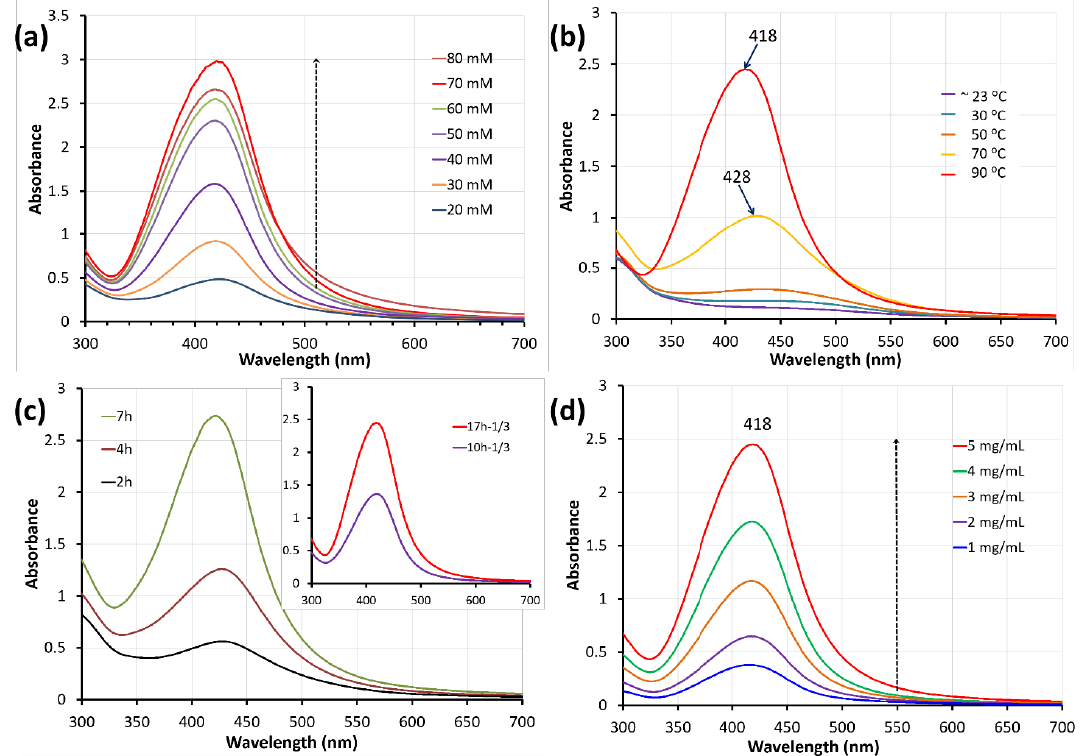
Figure 1. UV–Vis spectra of synthesized CS-capped AgNps in different conditions: ( a ) different AgNO 3 concentrations ((CS) = 5 mg/mL; 90 ◦ C; 17 h); ( b ) different temperatures ((CS) = 5 mg/mL; (AgNO 3 ) = 70 mM; 17 h); ( c ) different reaction times ((CS) = 5 mg/mL; (AgNO 3 ) = 70 mM; 90 ◦ C); ( d ) different CS concentrations ((AgNO 3 ) = 70 mM; 90 ◦ C; 17 h).